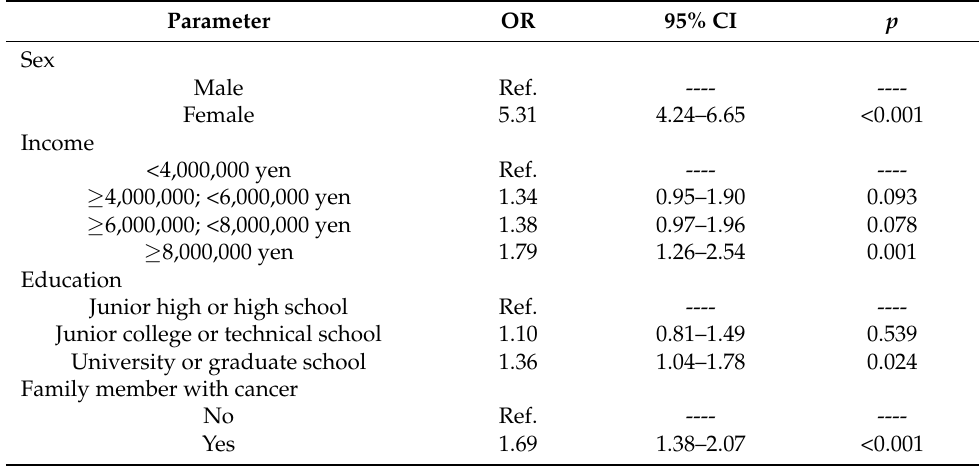
Table 3. Factors associated with cancer screening